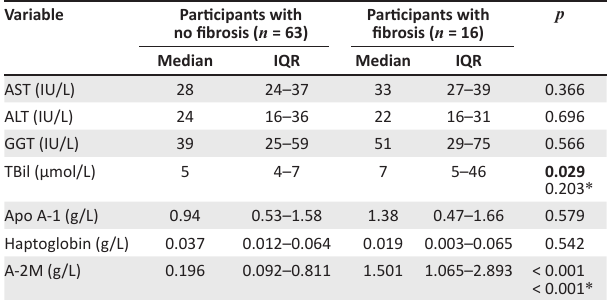
TABLE 3: Comparison of biomarkers in participants with significant fibrosis and those without as defined by the FibroTest. Variable Participants with Participants with no fibrosis ( n = 63) fibrosis ( n = 16)